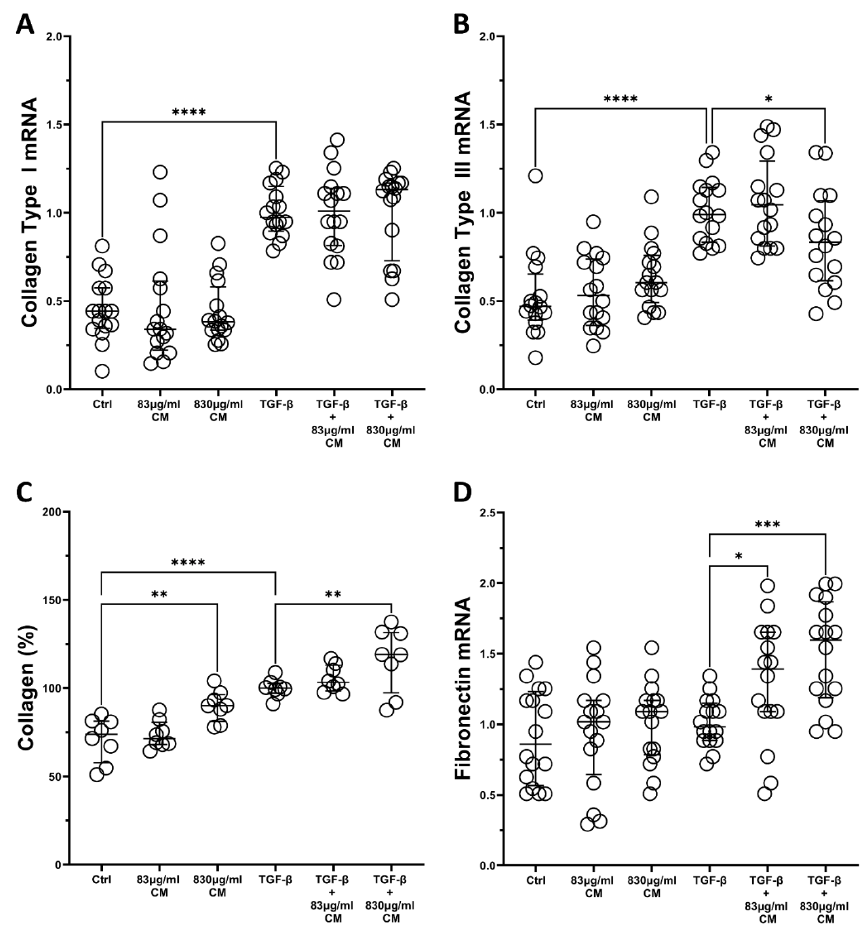
Figure 7. The effect of CM on fibrotic expression in hPSMs, which are under pro-fibrotic stimuli. Both CM doses do not alter the TGF- β -inducible mRNA expression of Collagen Type I ( A ), the higher CM dose downregulates the mRNA expression of collagen Type III ( B ), but upregulates the protein production of total secreted collagen ( C ), and both CM doses upregulate the TGF- β -inducible mRNA expression of fibronectin ( D ). TGF- β : 5 ng/mL; 830 μ g/mL total protein of CM; 83 μ g/mL total protein of CM. Results are presented as median with interquartile range. **** p < 0.0001; *** p < 0.001; ** p < 0.01; * p < 0.05. N = 4.